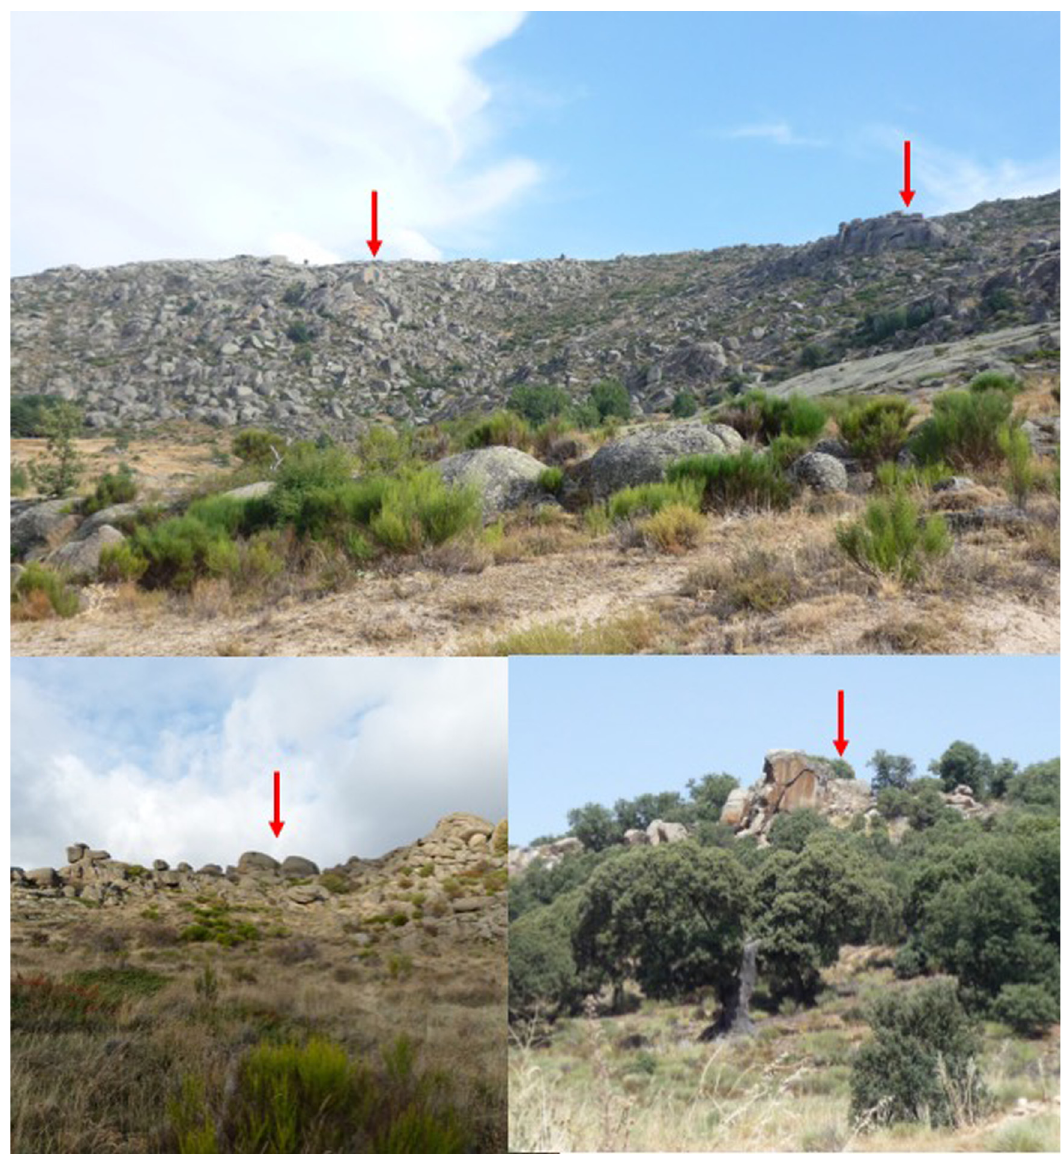
Figure 2: View of some of the Neolithic sites in the Amblés Valley: Umbría de Robledillo ( top left ) and Cueva de los Moros ( top right ) , at Robledillo; bottom left, Canchera Alta I, Muñotello; bottom right, Peña del Águila,